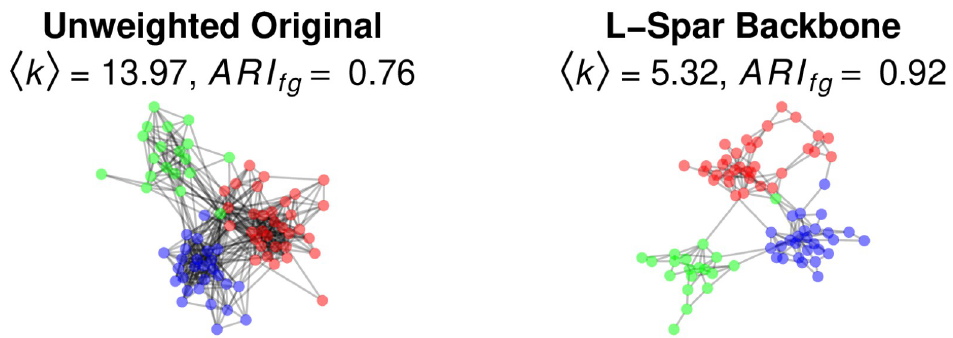
Fig 8. Extracting the backbone of an unweighted network of faculty email